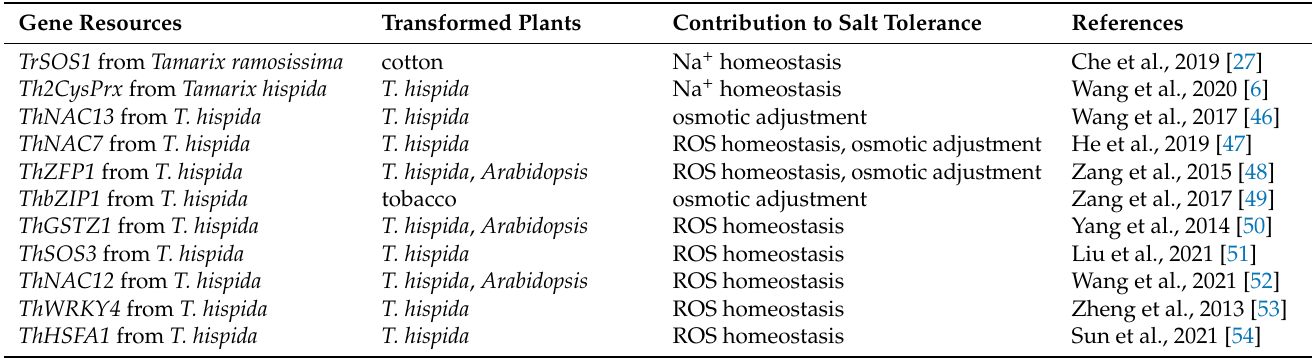
Table 1. The genes from tamarisk were expressed in plants and enhanced salt tolerance of transformed plants by regulating Na + homeostasis, osmotic adjustment, and ROS